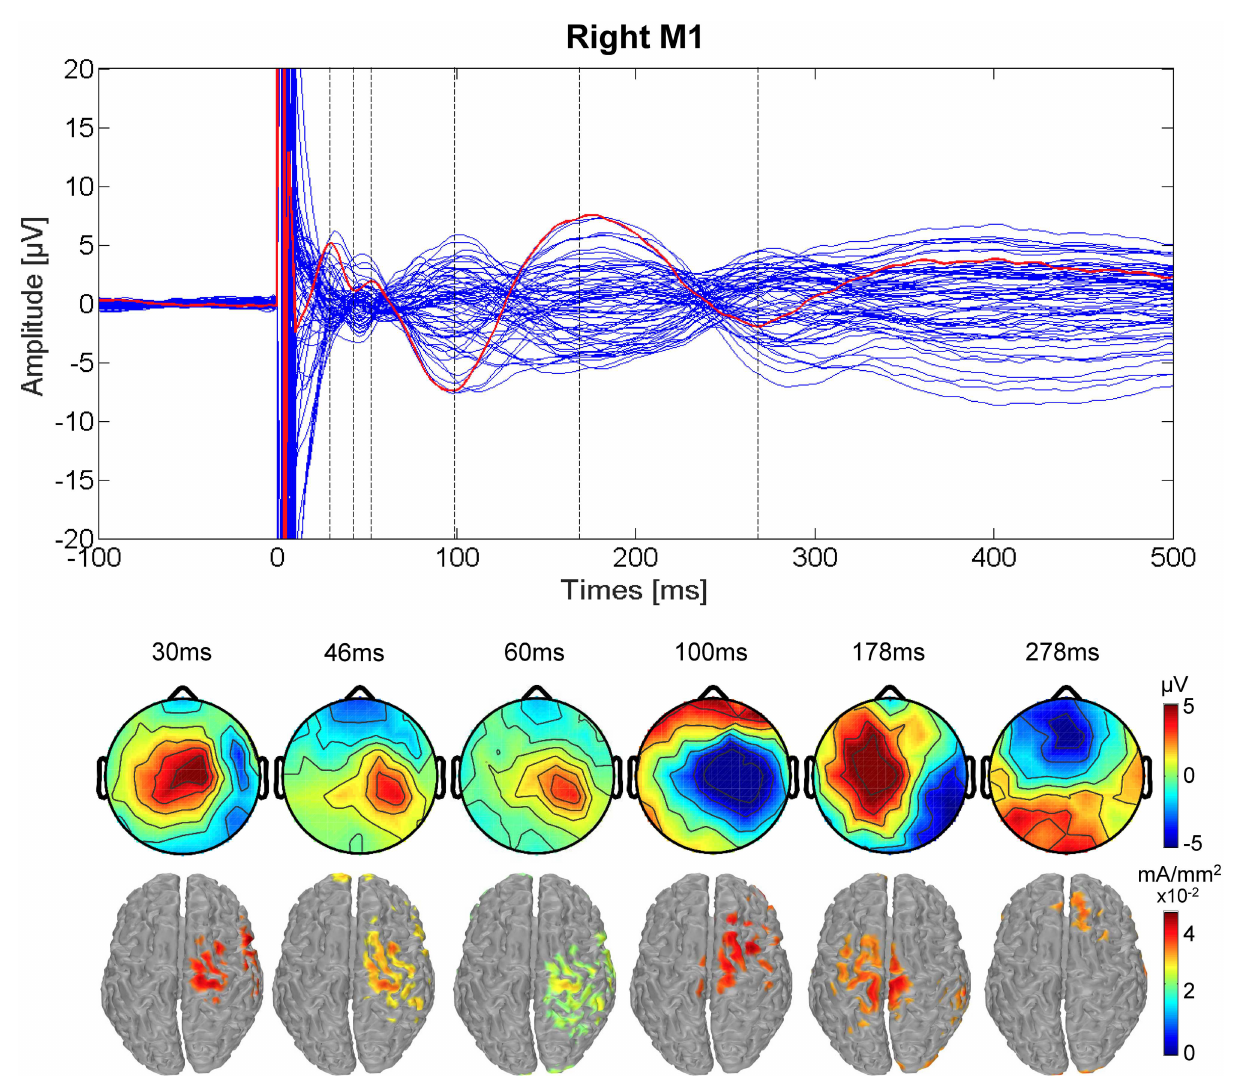
Fig 2. TEPs for right M1 stimulation. (Upper) Butterfly plot of the averageTMS-evoked activity from all electrodes(average of all 17 participants). Red line indicatesCz electrode. Timing of the peaks is indicatedby vertical dashed lines. (Lower) Voltage distributions(top) and Minimum Norm estimates (bottom) of the TMS-evoked activity for each peak in the Cz waveform. The cortical current density estimates have beenthresholdedto show the maximal activity at each